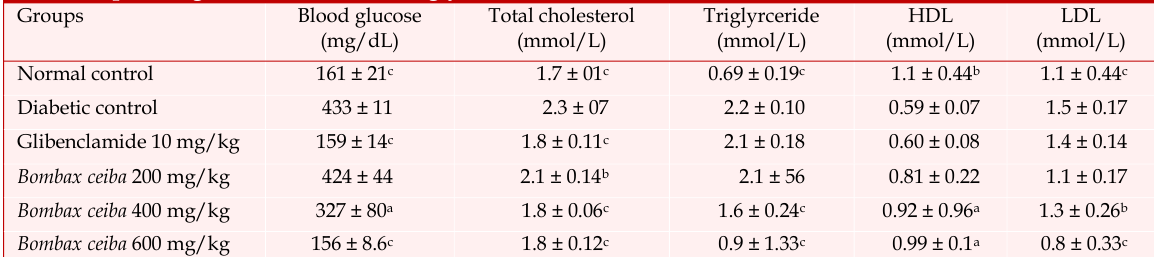
Effect of 21 daily dose of various concentration of Bombax ceiba bark ethyl acetate extract on fasting plasma glucose, cholesterol, triglycerides, HDL and LDL concentrations of STZ-treated rats Groups